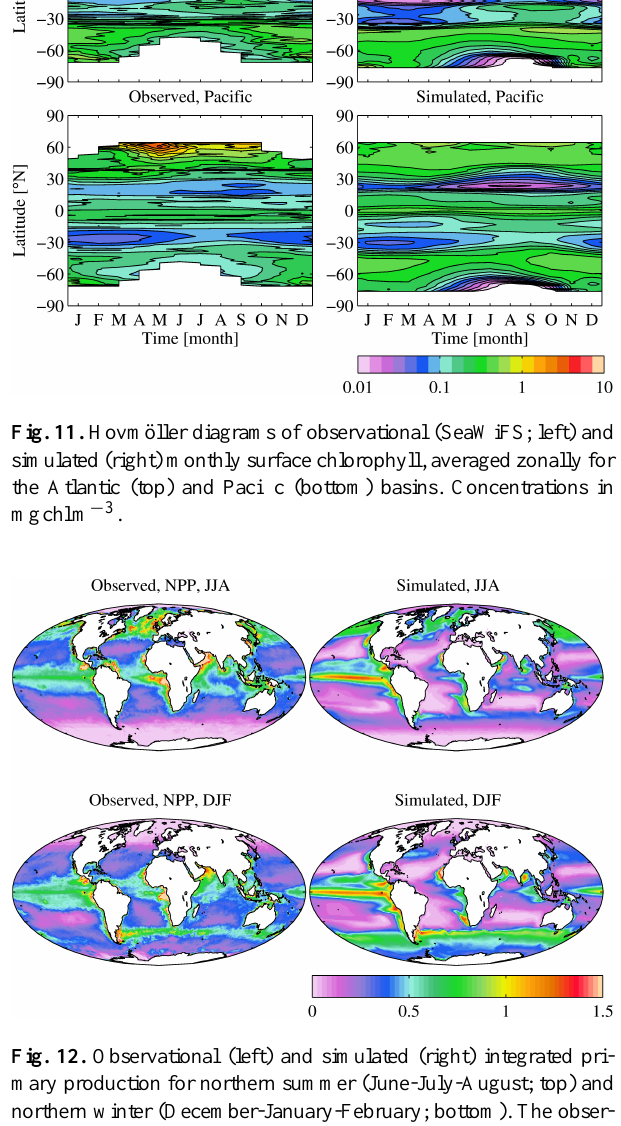
Fig. 14. Hovm¨oller diagrams of observational (left) and simulated (right) monthly integrated primary production, averaged zonally for the Atlantic (top) and Pacific (bottom) basins. Production in g C m − 2 d − 1 .